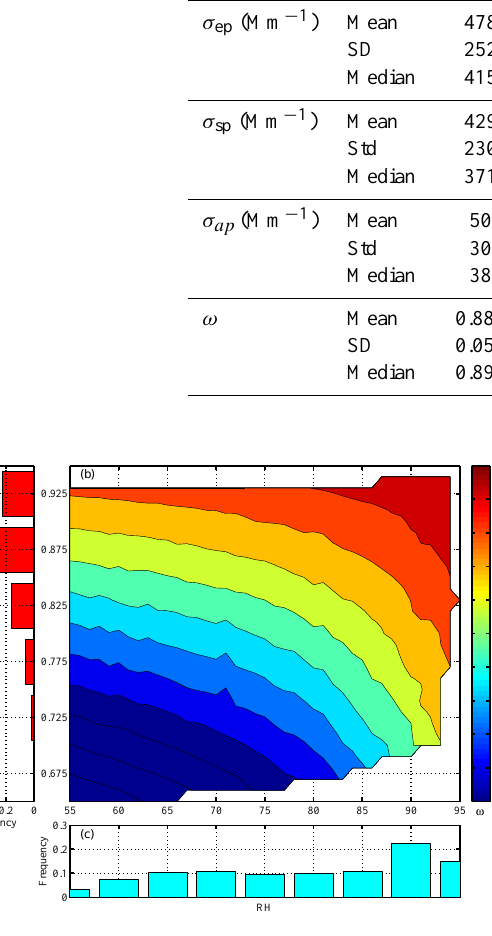
Figure 4. Frequency distributions of ω 0 and RH (respectively, a and c ). Calculated ω at given ω 0 and RH (b)